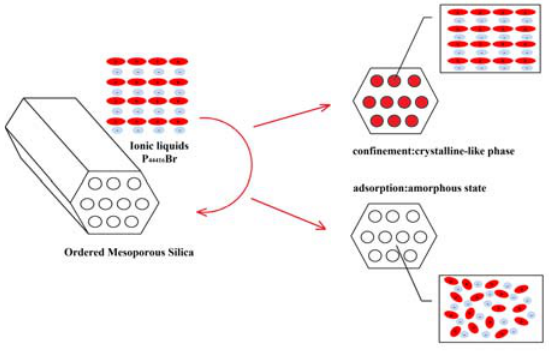
Figure 4. XRD patterns of the bulk P pattern of sample P